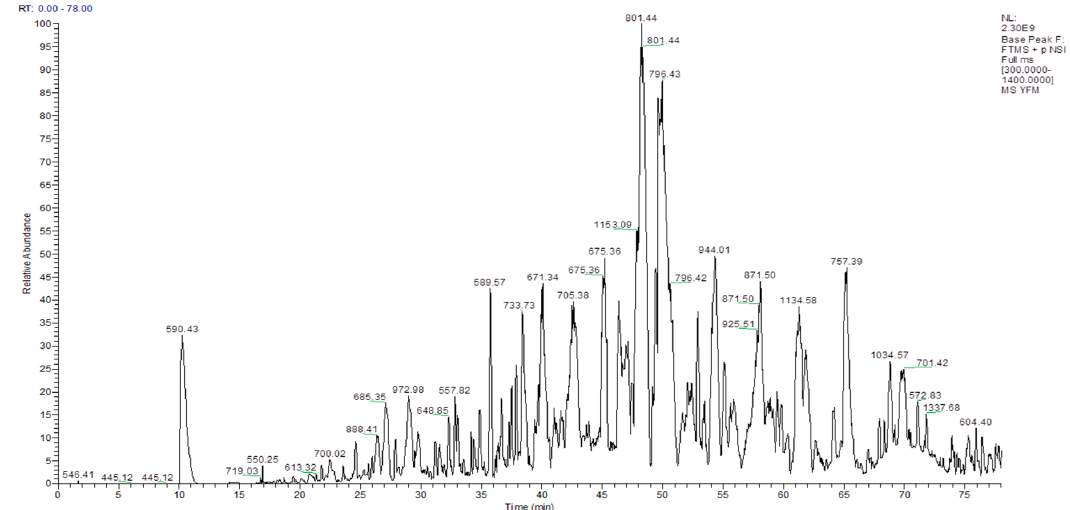
Figure 1. Total ion chromatogram of small molecular peptides (SMPs). Table 1. Composition and contents of amino acids of